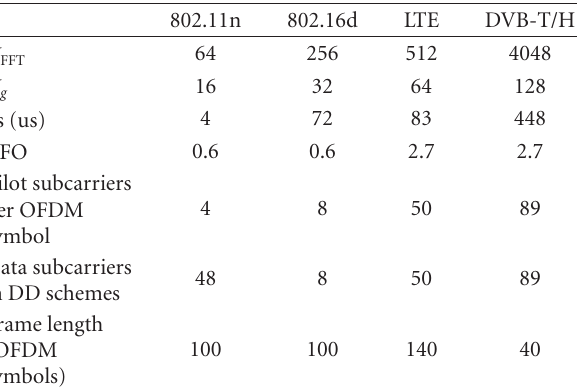
Table 1: P arameters for the di ff erent standards.